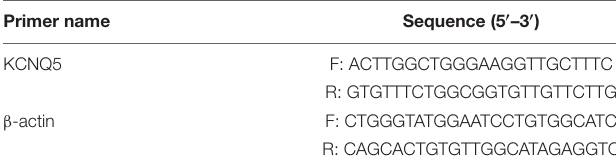
TABLE 1 | Primer sequences for quantitative